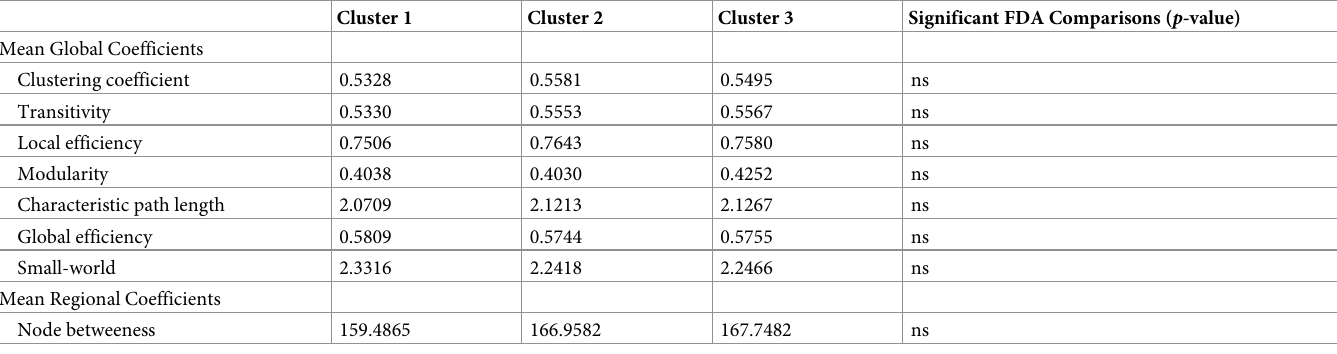
Table 5. Gyrification network comparisons of topological measures.